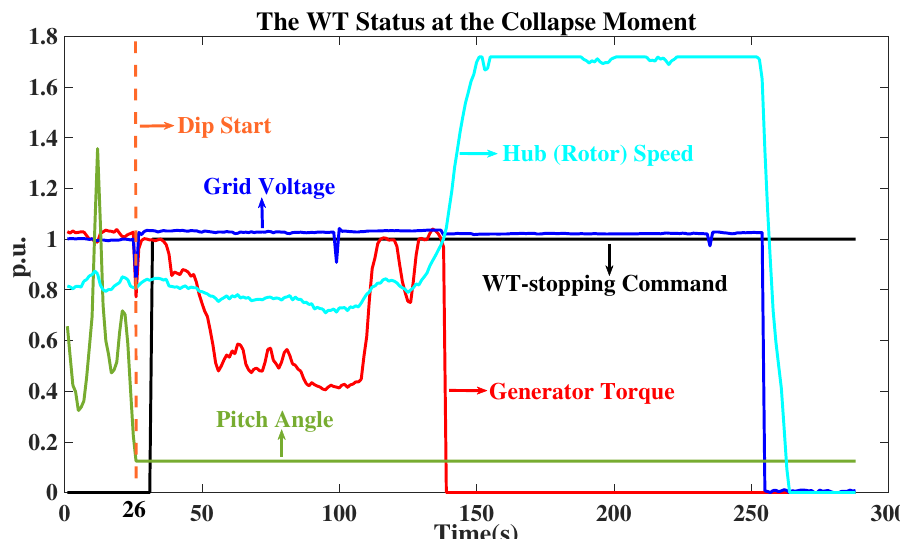
Figure 7. The operating status of the WT at the moment of collapse. The p.u. values of the rotor speed, generator torque, pitch position, and grid voltage are 20.35 rpm, 100 N · m, 10 ◦ , and 380 V, respectively.